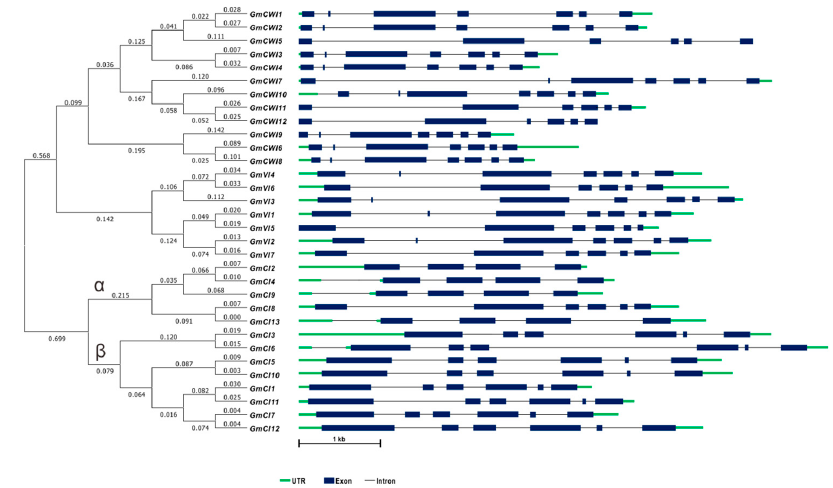
Figure 1. Cluster of soybean invertase gene candidates and their schematic gene structures. Exons and untranslated region (UTR) are indicated by dark blue boxes and green lines, respectively. Introns are represented in black lines. CIs were separated into α clade and β clade according to conserved amino acid sequences.